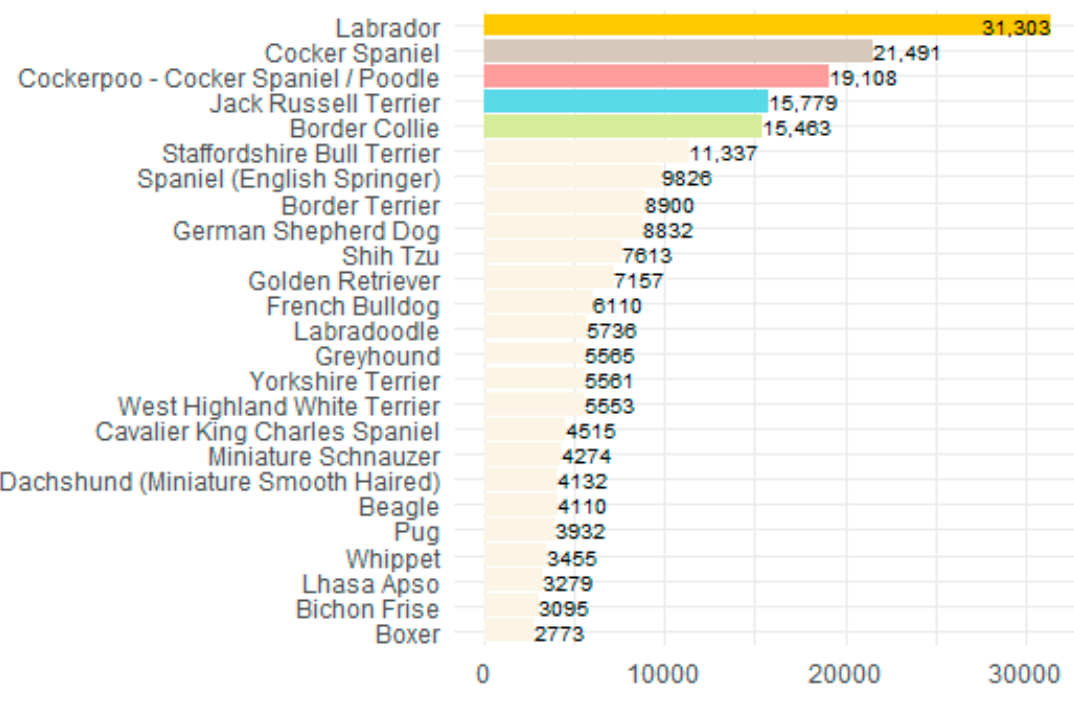
Figure 2. The 25 most common breeds reported by owners. The top 5 breeds are represented by individual colours for clarity.